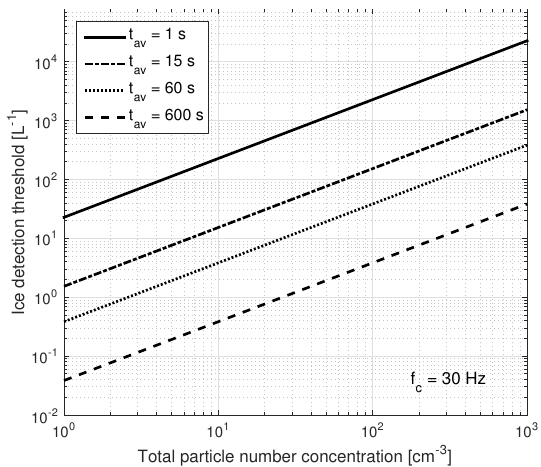
Figure 7. The SID-3 and PPD-2K ice detection threshold as a func- tion of the total particle number concentration. The concept of the detection threshold can be generalized from ice particles to all spe- cific particle types distinguishable by means of SID-3/PPD-2K scat- tering